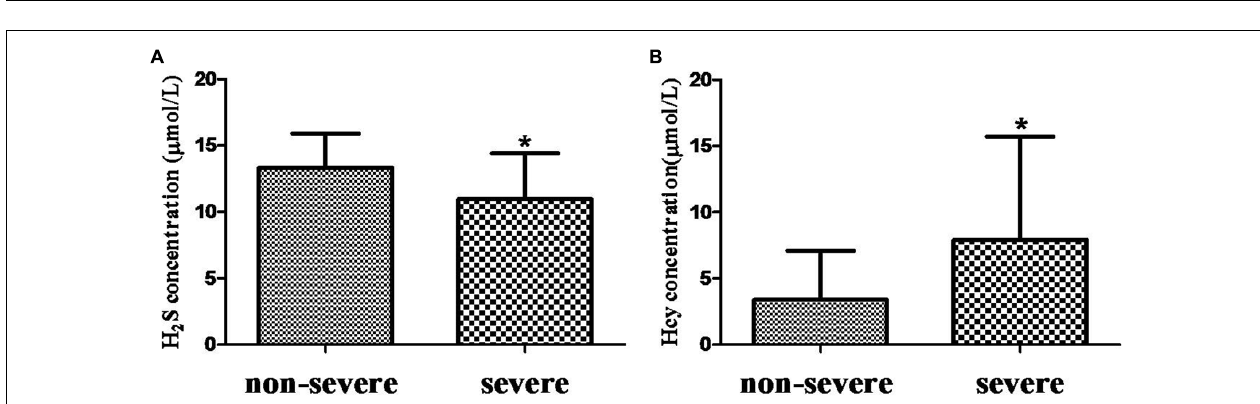
FIGURE 1 | The serum H 2 S, Hcy and H 2 S/Hcy ratio in COPD and COPD + CVD groups. (A) Serum H 2 S concentration in both groups; (B) Serum Hcy concentration in both groups, (C) The ratio of H 2 S/Hcy in both groups. The data are described as mean ± SD. ∗ P < 0.05 versus COPD.